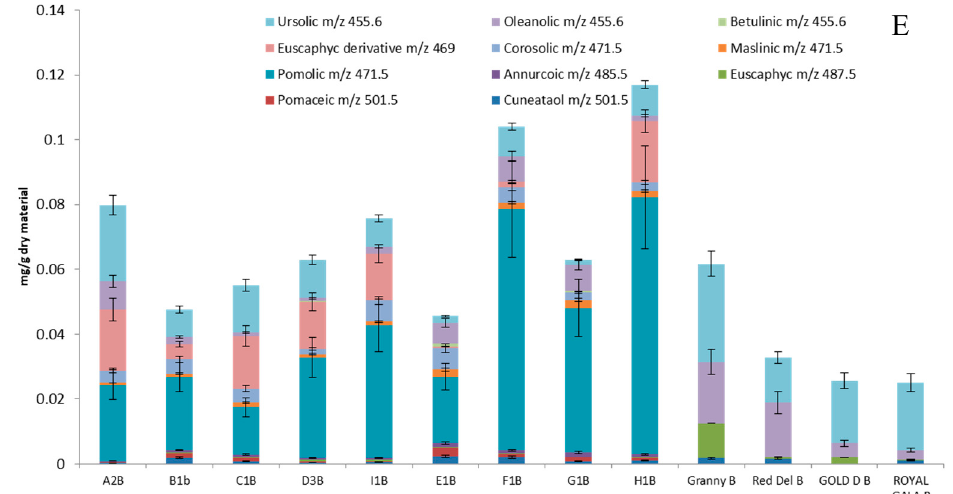
Figure 6. Contents, mg/g on dry material, of flavan-3-ols and procyanidins ( A ), flavonoids ( B ), chalcones ( C ), hydroxycinnamic acids ( D ) and triterpene acids ( E ) in apple pulps. In the X axis: Granny: ‘Granny Smith’, Red Del: ‘Red Delicious’, Gold D: ‘Gold Delicious’.